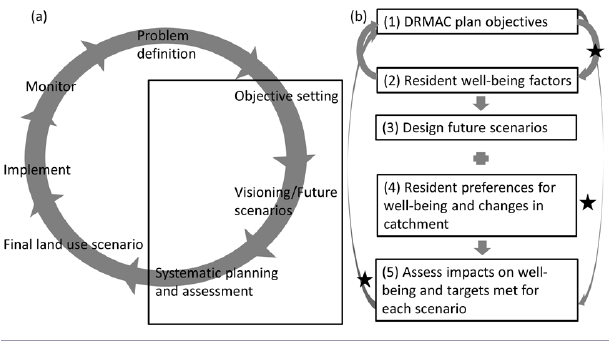
Fig. 2 . The planning and engagement process for the Daly River catchment, designed in collaboration with the Daly River Management Advisory Committee (DRMAC). (a)